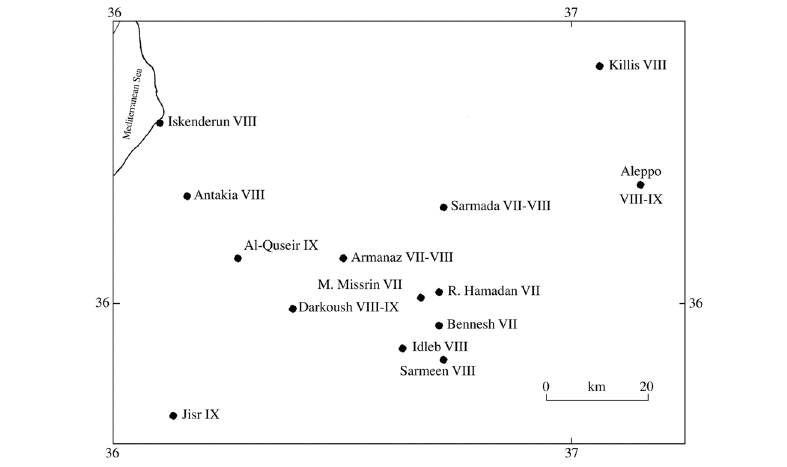
Fig. 14. Detailed map of intensity distribution for August 13, 1822 earthquake, between Antakia and